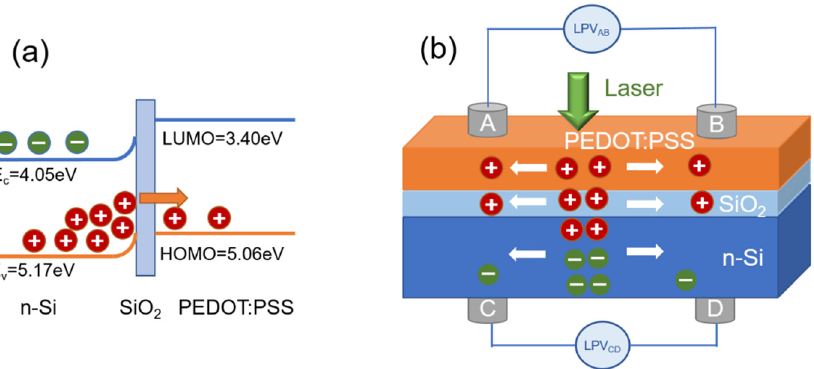
Figure 3. ( a ) The energy band diagram and ( b ) diagram of LPE mechanism in Si/SiO 2 /PEDOT:PSS.